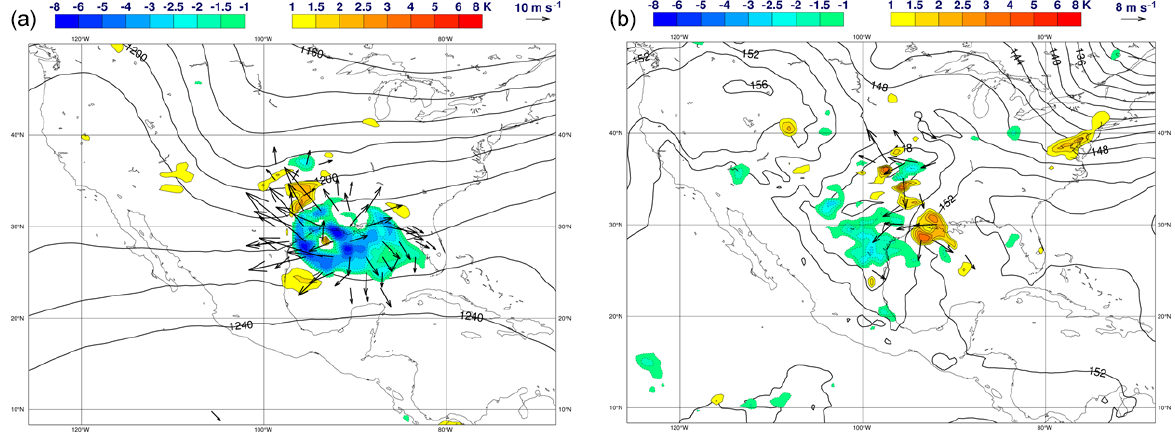
Figure 9. (a) ECMWF operational analysis of geopotential at 200hPa (continuous isolines), temperature analysis increments at 150hPa (colour shaded, units Kelvin) and wind vector analysis increments at 150hPa (arrows, units ms − 1 ), valid on 3 May 2017, 12:00UTC. (b) as left, all quantities at